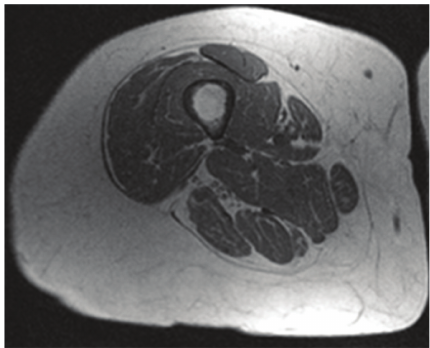
Figure 1: Representative image of mid thigh region showing cross- sectional area of lean and IMAT.